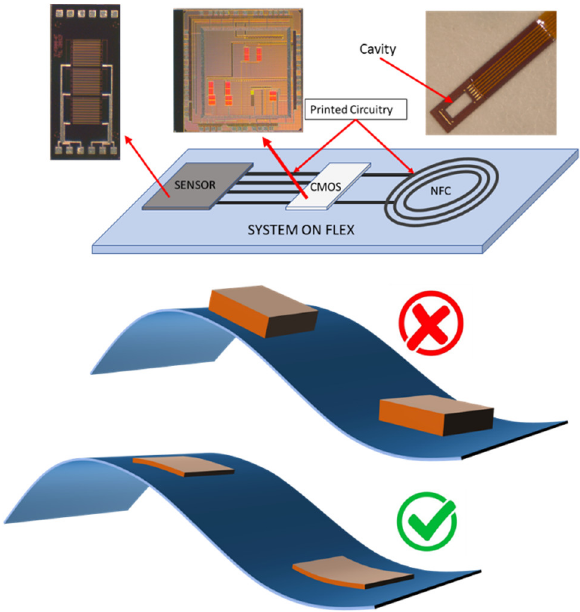
Figure 1. Hybrid integration of silicon-based components on flexible substrates; the advantage of ultra-thinned chips to leverage the flexibility of the whole system.